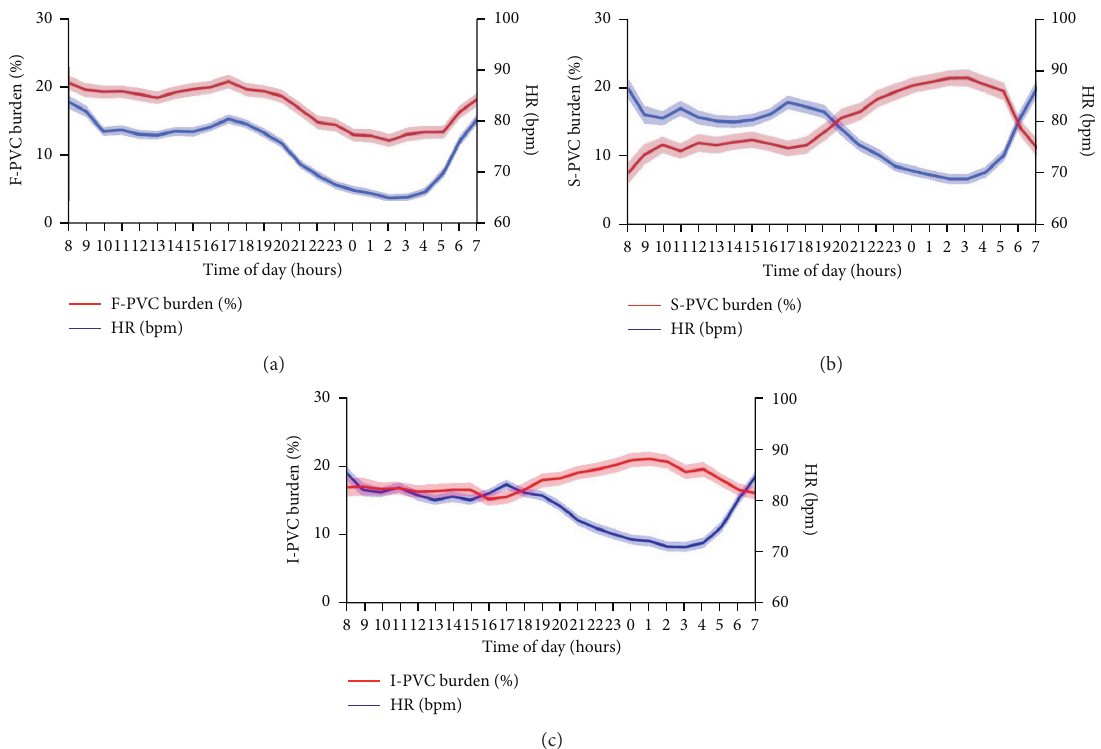
Figure 1: Circadian variability of PVC burden. Circadian rhythms of PVC burdens (as a percentage) and HR in F-PVC (a), S-PVC (b), and I-PVC (c). HR, heart rate; PVC, premature ventricular